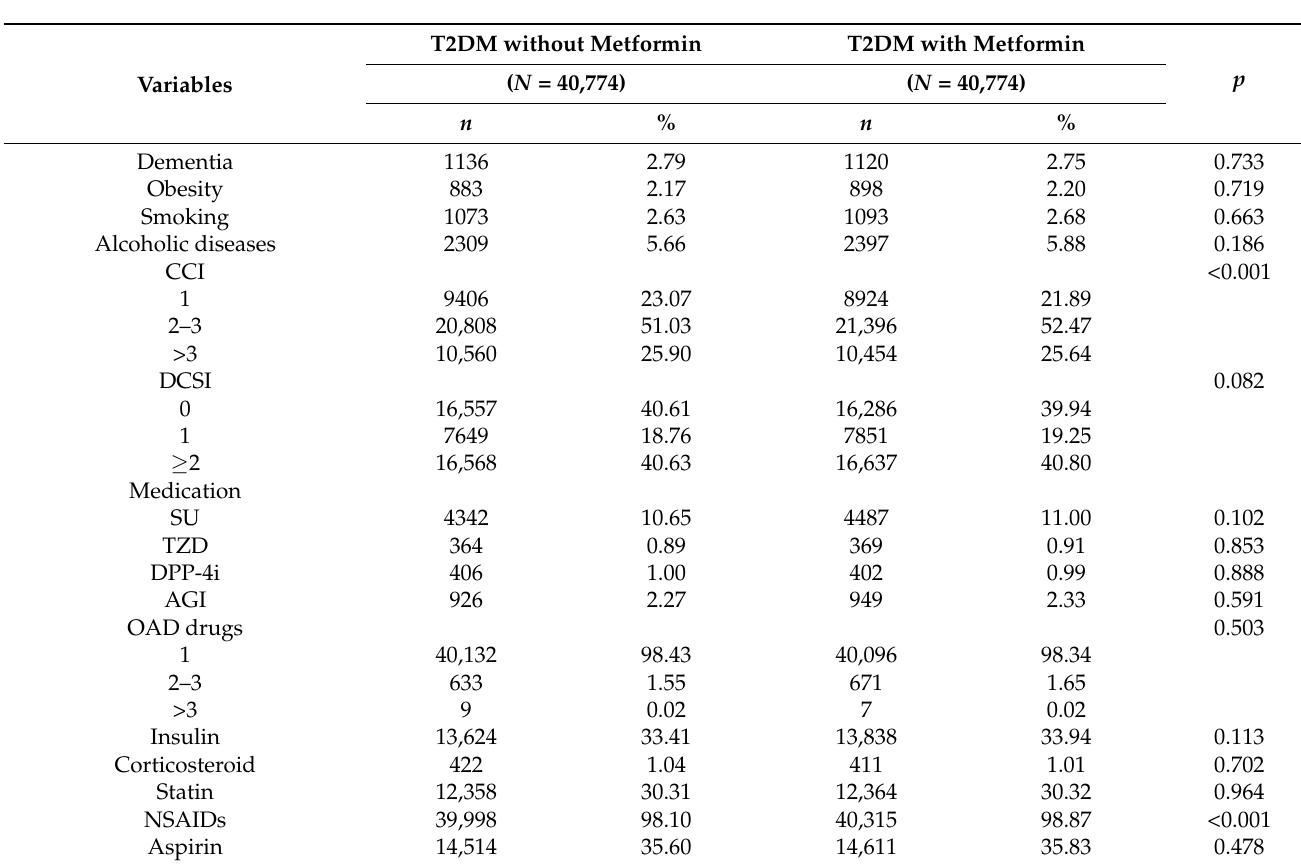
construct 40,774 pairs of metformin users and nonusers. In the matched cohorts (Table 1), 46.73% of patients were female; the mean (SD) age was 56.53 (13.06) years. The